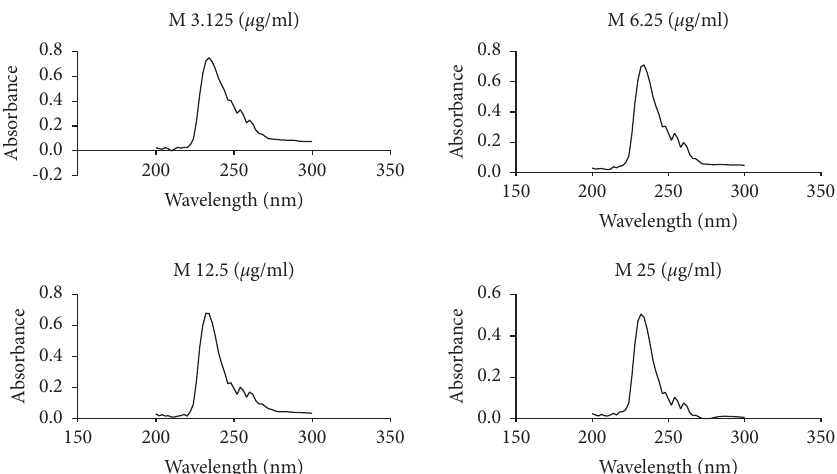
Figure 9: Absorbance spectra of ergosterol from C. albicans cells exposed to miconazole. Cell pellet was exposed to miconazole con- centrations of 3.125 μ g/ml, 6.25 μ g/ml, 12.5 μ g/ml, and 25 μ g/ml of miconazole (M). The graphs show the UV/Vis scan from 200nm to 300nm.